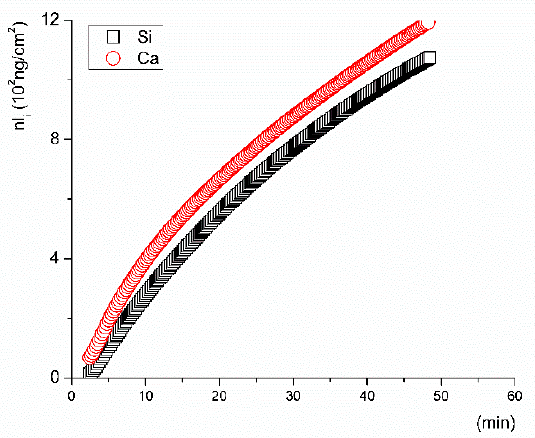
Figure 3. Inline ICP test results for ion release from the Vitryxx bioactive glass (VB) in the SBF solution with results expressed in terms of the weight concentration, i.e., mg of ion per liter of solution.